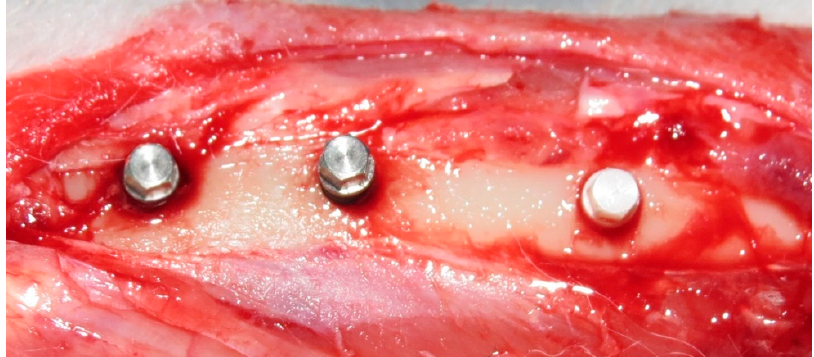
Figure 3. Representative image of the implant samples installed in an animal bone tibia.